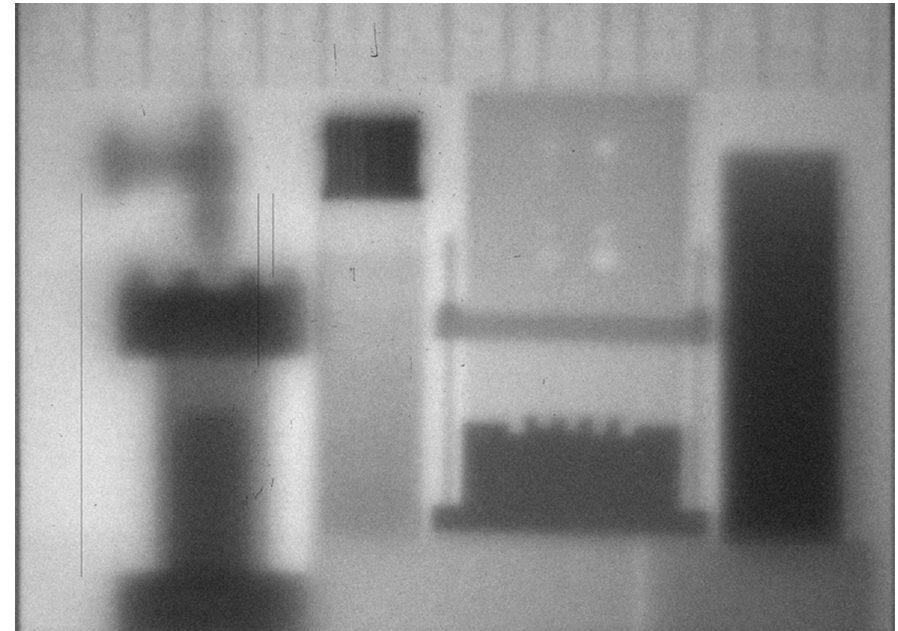
Figure 1. Neutron radiograph taken with a single laser-driven pulse at the TRIDENT laser at LANL (after [34]). The radiation penetrated a thick aluminum chamber window before reaching the objects and detector. The detector was an a-Si flat panel with a polypropylene plus ZnS:Cu neutron converter/scintillator. Objects from left to right include, a stainless steel and brass vacuum valve, a Ta and polyethylene line pair gauge sitting on top of a polyethylene step wedge, a steel, aluminum and polyethylene phantom and a tungsten wedge. The left side objects show greater blur due to the angle of neutron emission from the source.